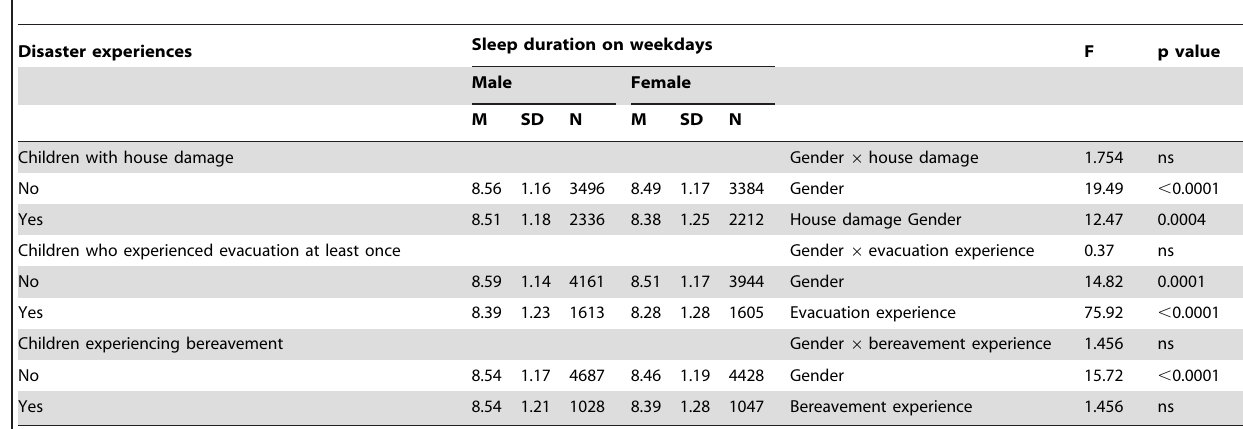
Table 7. Average sleep duration on weekdays (number of disaster experiences and gender).